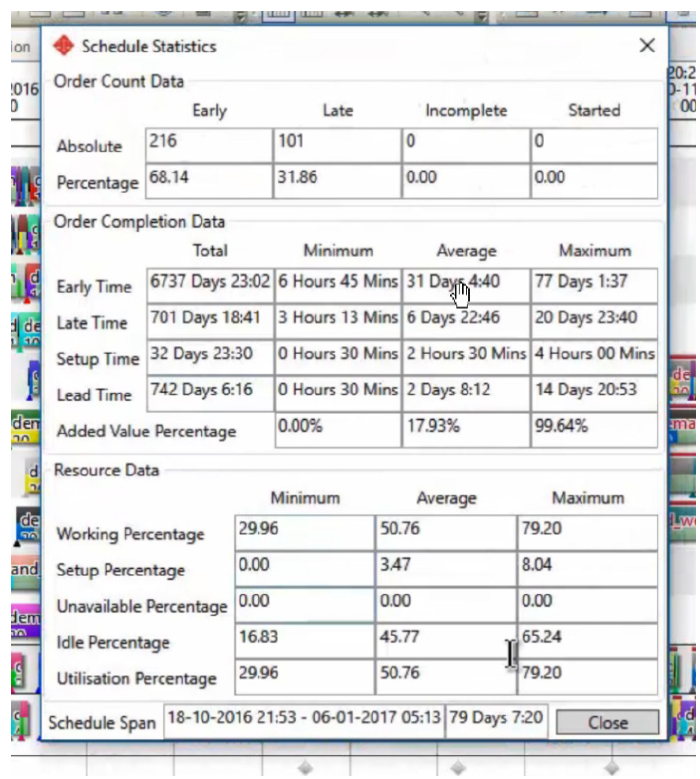
Figure 7. Forward Scheduling-Siemens Opcenter APS preview.